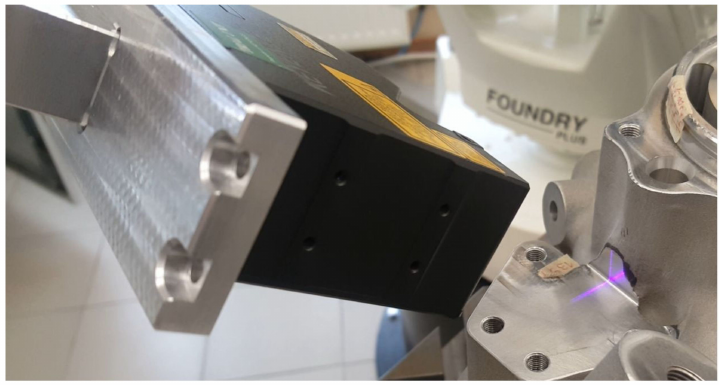
Figure 9. Robotised fillet radius inspection in one of the locations.